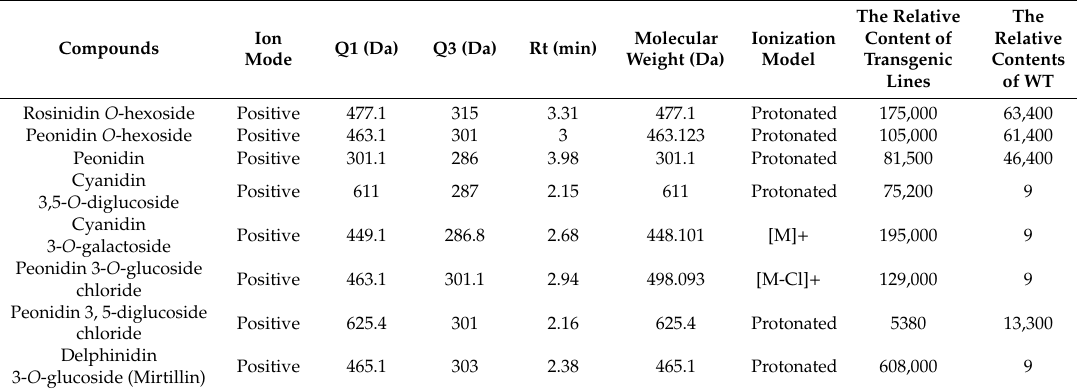
Table 1. Anthocyanin components and relative contents in the grains of transgenic and WT wheat based on metabolome analysis.